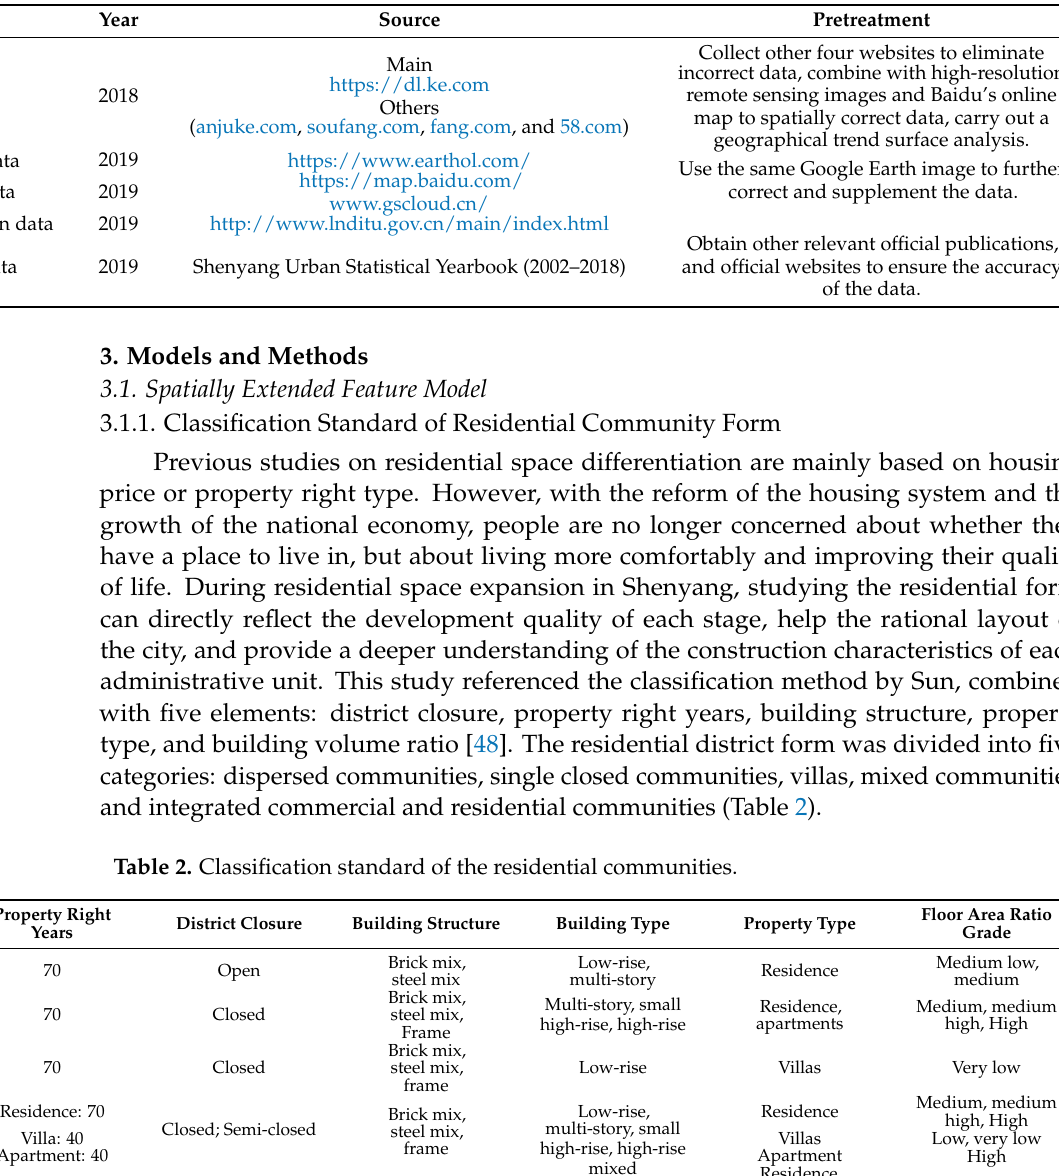
Table 1. Data description.